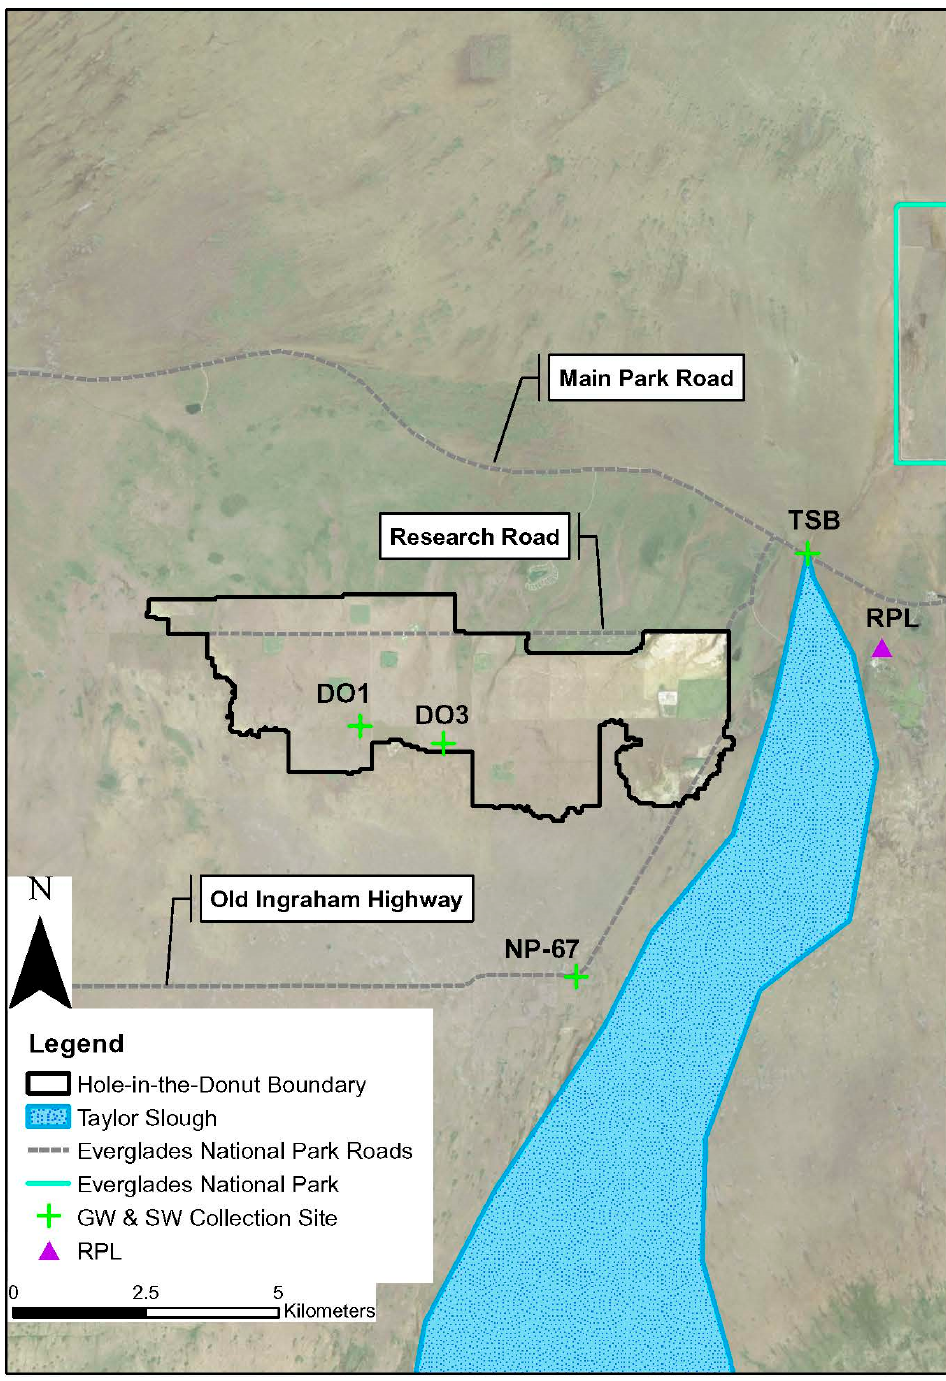
Figure 2. The Hole-in-the-Donut as visible from satellite imagery (courtesy of ESRI, 2022). A green cross symbolizes a groundwater (GW) and surface water (SW) collection site and the purple triangle denotes a rain collection station. DO indicates a monitoring well inside the HID; TSB corresponds to ‘Taylor Slough Bridge’; NP indicates ‘National Park’; and RPL is ‘Royal Palm’. The entirety of the HID is underlain by the highly permeable units of the Biscayne Aquifer, and overlain by mixtures of marl and peat soils of lower hydraulic conductivity [41]. Left in place, the marl and peat soils may impede the interactions between groundwater and surface water in the area. Upon removal of the topsoil in the HID, the potential for groundwater and surface water interaction is expected to increase.